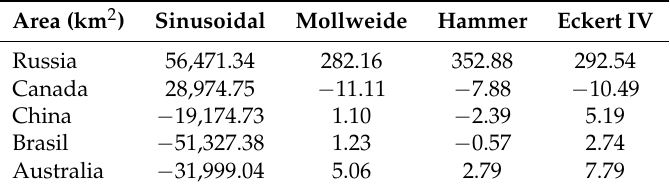
Table 5. Differences in the area of five large countries, respective to the Homolosine projection, computed with QGis